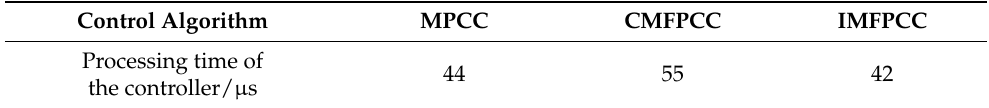
Table 2. Processing time of the controller for the three